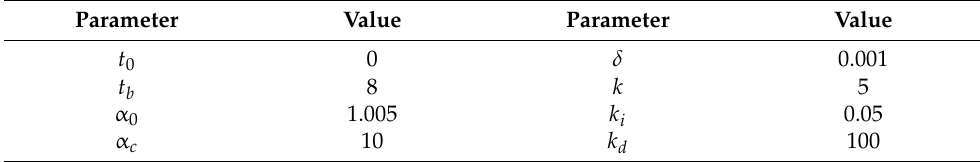
Table 3. Controller parameters for experimentation.